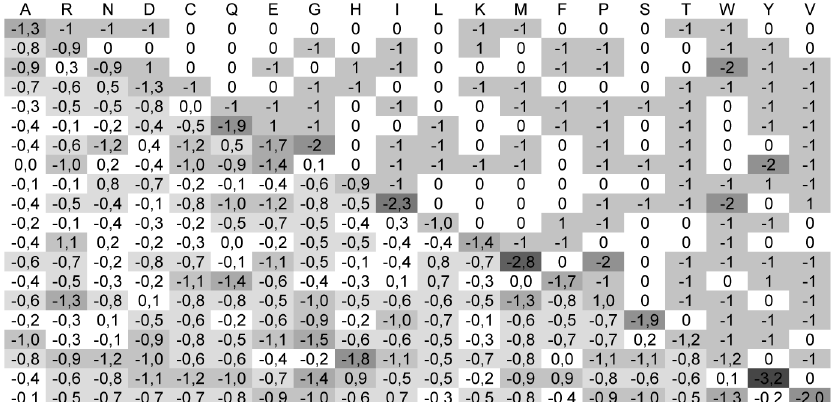
Figure 5. The differences between original BLOSUM62 matrix and its reconstruction. The matrix was reconstructed using G-matrix and 5 eigenvectors derived from BLOSUM100 matrix. The triangle above diagonal displays differences between matrices scaled to half bit units and rounded, the diagonal and triangle below displays differences between matrices scaled to half bit units and not rounded. The shades of gray correspond to the differences.